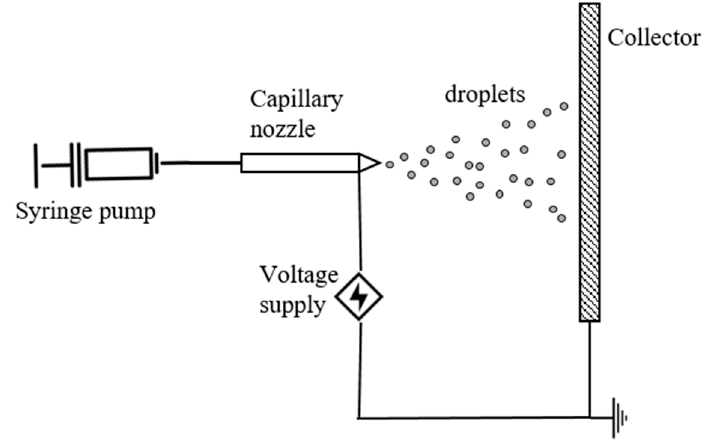
Figure 1. Schematic representation of an electrospraying process (adapted from Jaworek et al. [25]).